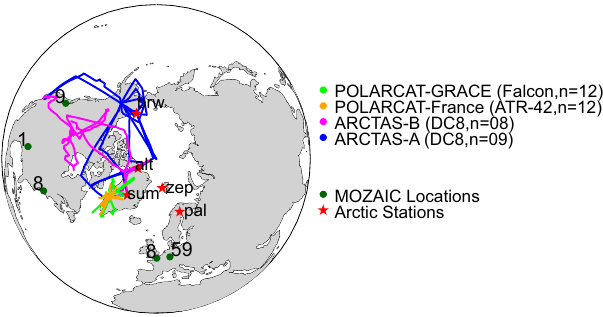
Figure 1. Location of surface stations used for comparisons in Figs. 2 and 3 (alt–Alert, brw–Barrow, pal–Pallas, sum–Summit, zep–Zeppelin), flight tracks of POLARCAT flights used to calcu- late vertical profiles in Figs. 7 and 8 (with n = number of flights used) and locations of the airports where MOZAIC descent and as- cent profiles were used over Europe and North America in Fig. 9 (the values denote the number of profiles at each